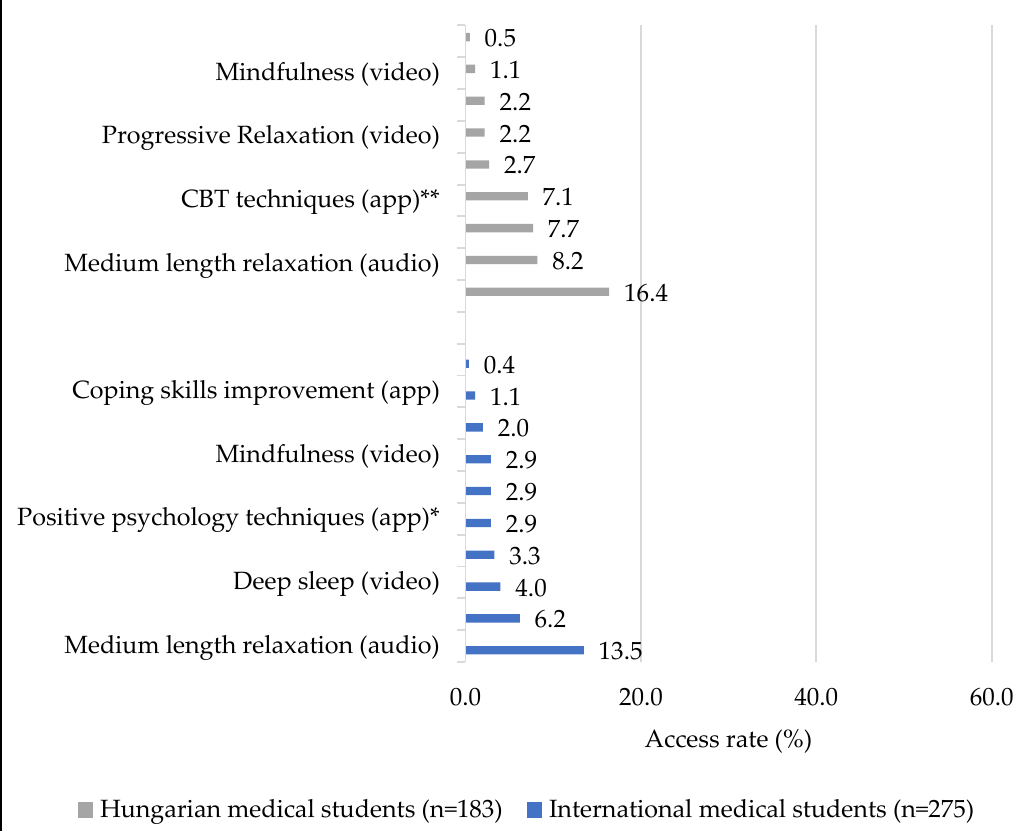
Figure 4. Access rate of stress-management materials separately by course type; * p < 0.05, ** p < 0.001.